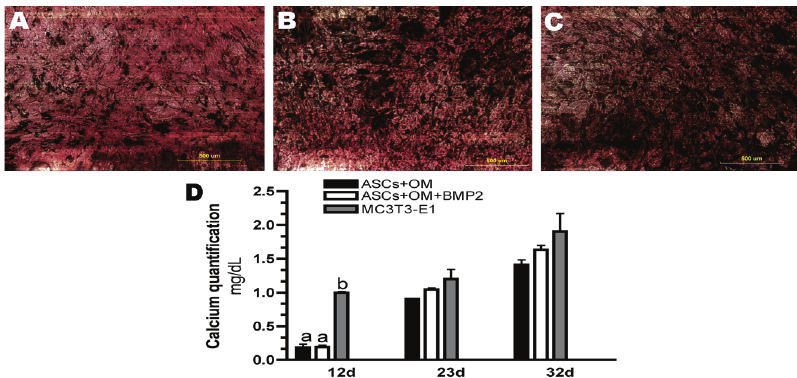
Figure 2- Extracellular matrix mineralization. A) Von Kossa staining. Adipose-derived stem cells (ASCs) with osteogenic medium (OM). Bar=500 μm; B) ASCs with OM supplemented with BMP-2; C) MC3T3-E1 cells (positive control); D) Calcium quantification at days 12, 23, and 32. Different letters refer to statistical significant differences (ANOVA/SNK,